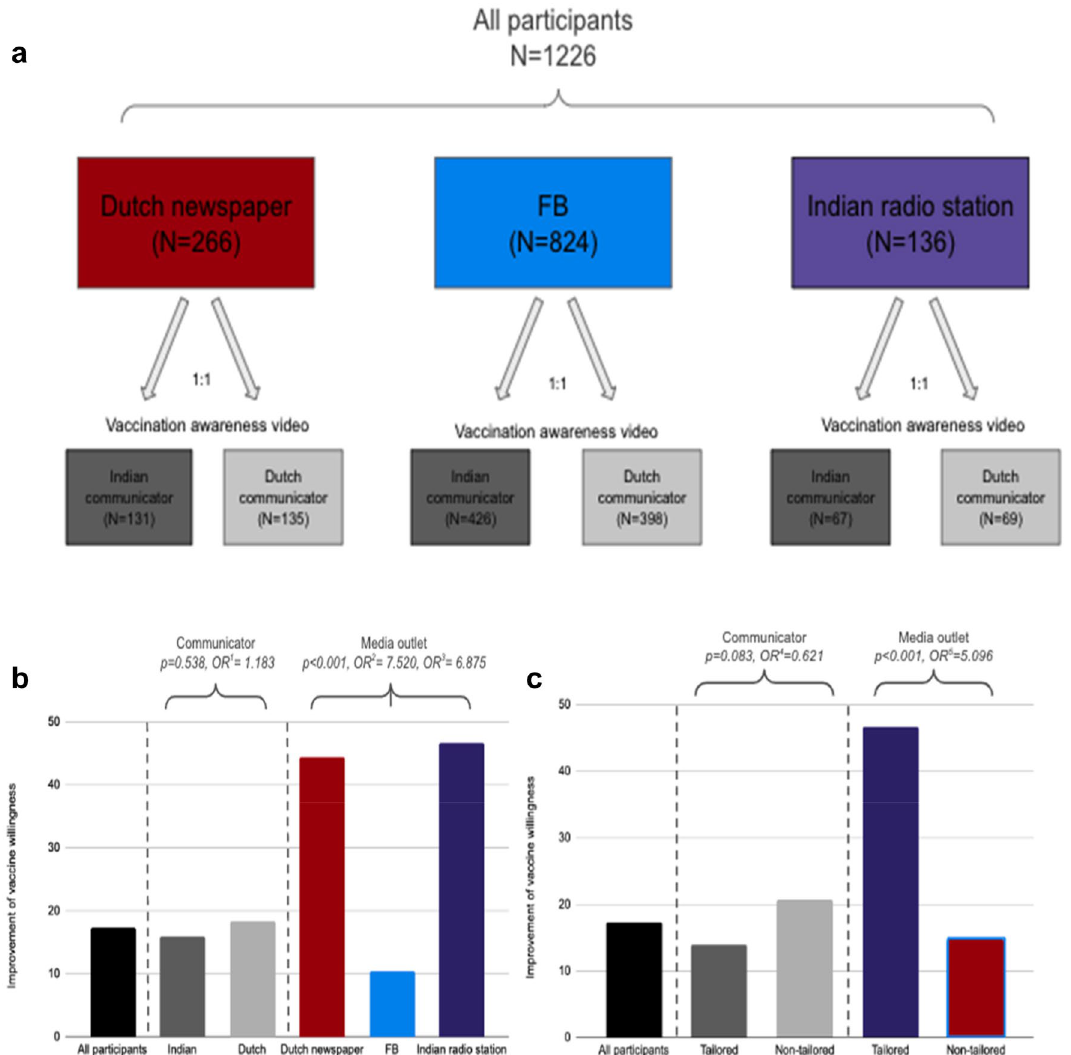
generated using binary logistic